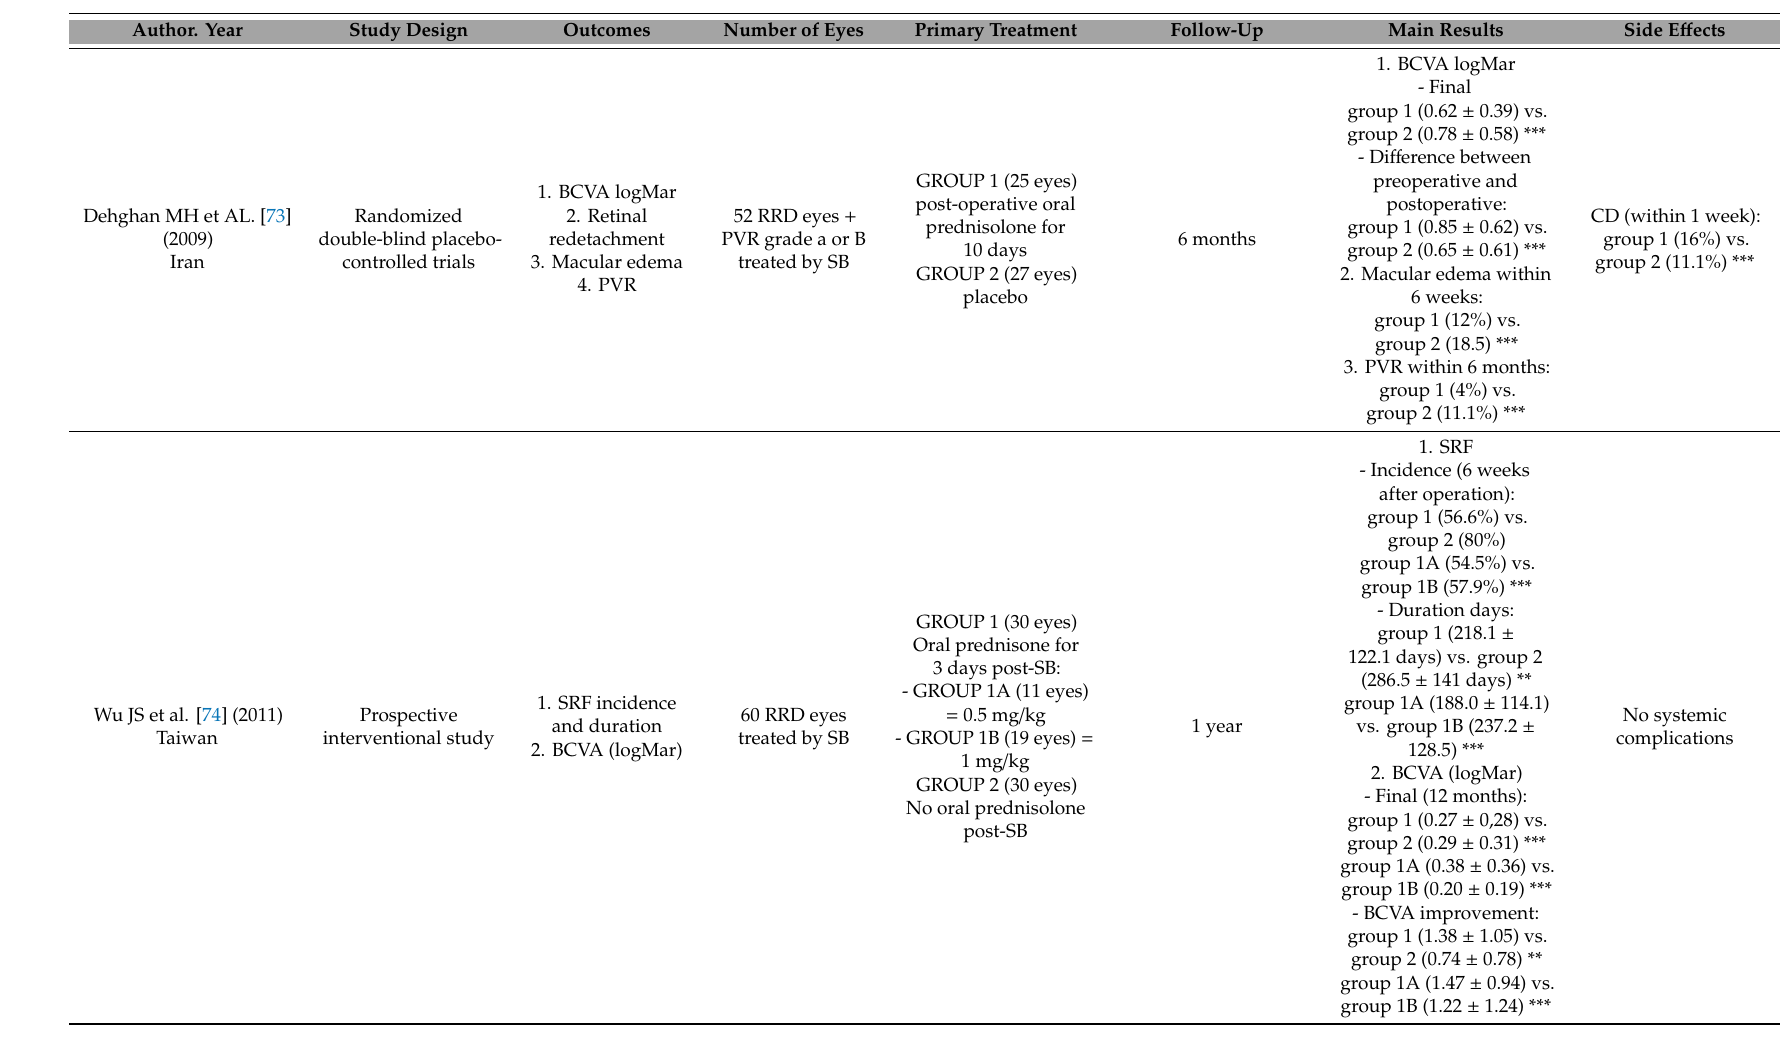
Table 3. Postoperative use of corticosteroids in retinal detachment